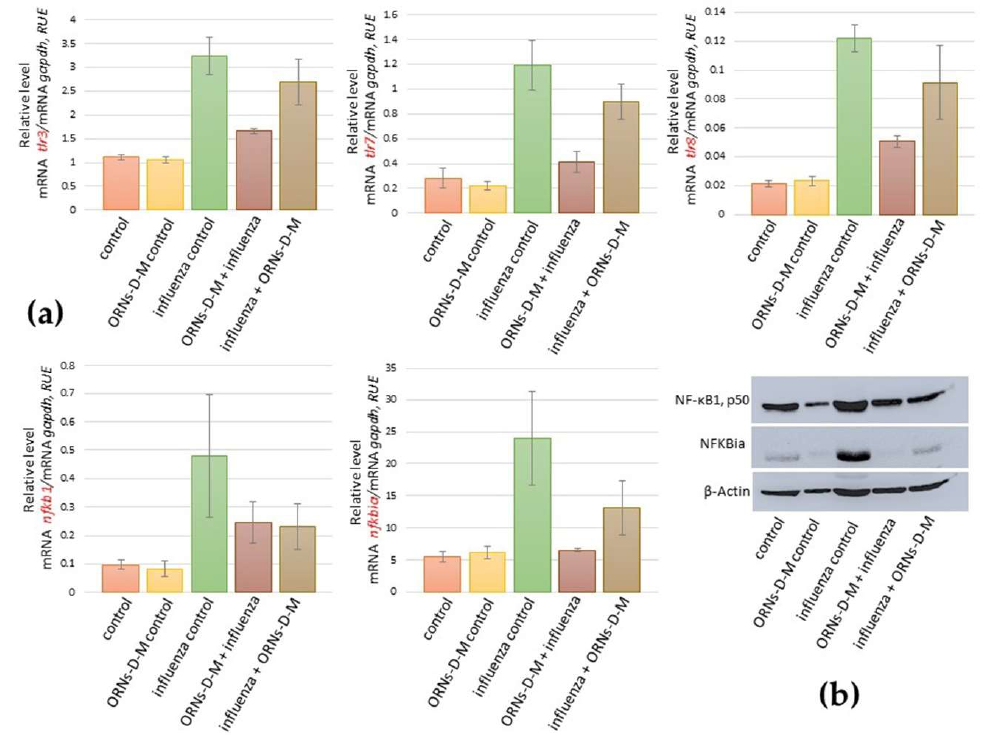
Figure 6. Impaired overexpression of the tlr3 , tlr7 , tlr8 , nfkb1 , and nfkbi α induced by the influenza virus A/Fort Monmouth/1/1947-mouse adapted (H1N1) owing to the ORNs- D -M in vivo . Before and after infection with the influenza virus FM147 (4.0 lg LD 50 ), the BALB/c mice were treated with ORNs- D -M. ( a ) Total RNAs from the mice lungs were isolated and RT-qPCR was performed. The mRNA levels of tlr3 , tlr7 , tlr8 , nfkb1 , and nfkbi α were normalized to gapdh as a control. RUE: relative units of expression. ORNs- D -M control—ORNs- D -M injection into healthy mice, influenza control—infection of mice with influenza virus, ORNs- D -M + influenza—ORNs- D -M injection 24 h before infection with the influenza virus and prevention with ORNs- D -M, and influenza + ORNs- D -M—ORNs- D -M injection 24 h after